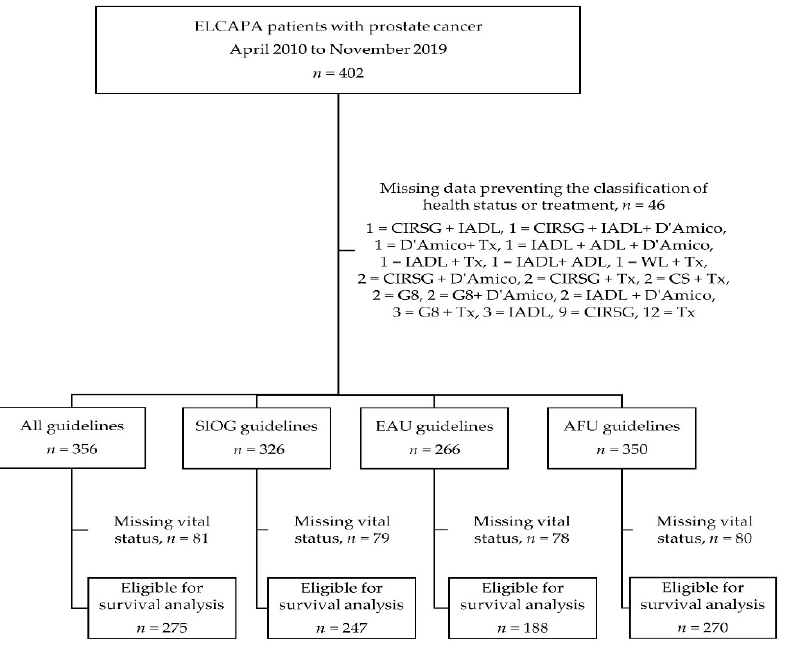
Figure 1. Flow diagram of participants and available data, depending on the set of guidelines. ADL: